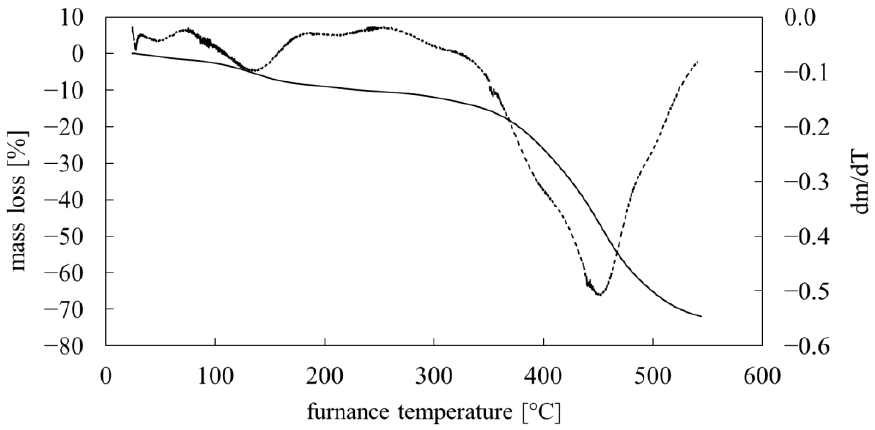
Figure 9. TG curve of PMFOS (mass loss versus temperature— solid line, first derivative of mass loss versus temperature— dotted line).